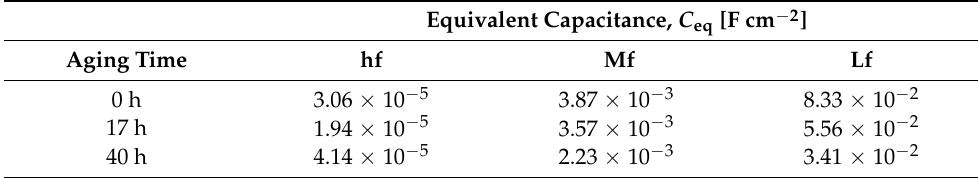
Table 3. Equivalent capacitances for the three mechanisms, calculated according to Musiani